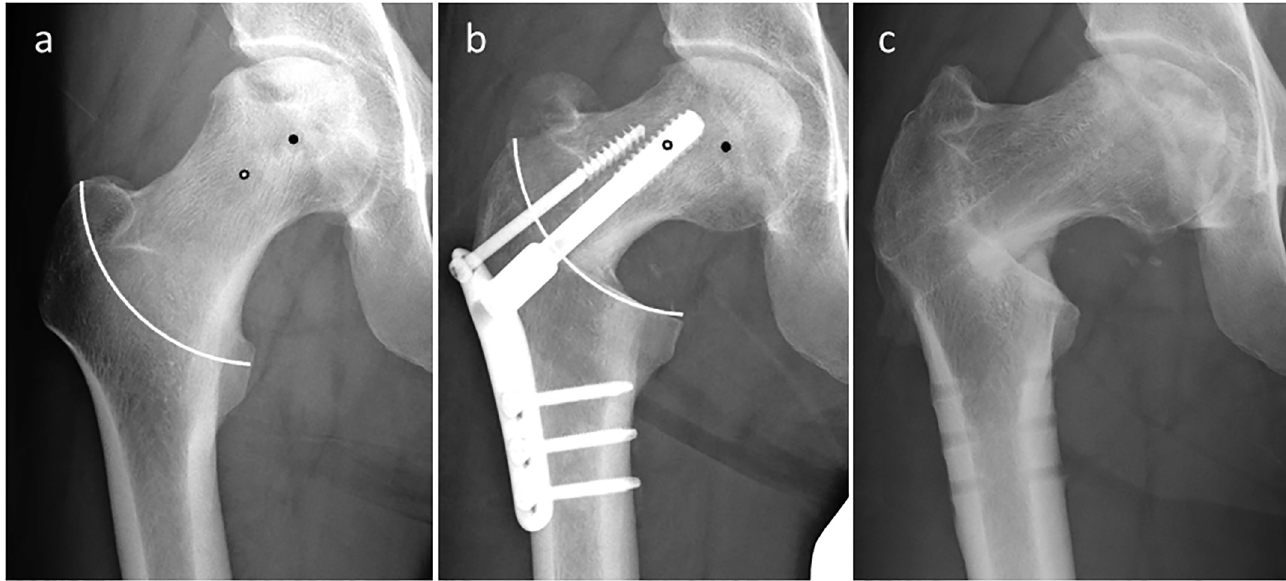
Fig 8. Radiographs of 39-year-old man who had steroid-associated osteonecrosis of the femoral head treated with curved intertrochanteric varus osteotomy. a) Before and b) after the operation. White line indicates the osteotomy arc. Black points indicate the center of the femoral head and white points indicate the center of the osteotomy arc. The actual leg shortening was 8.6 mm, whereas the theoretical leg shortening was 9.0 mm.